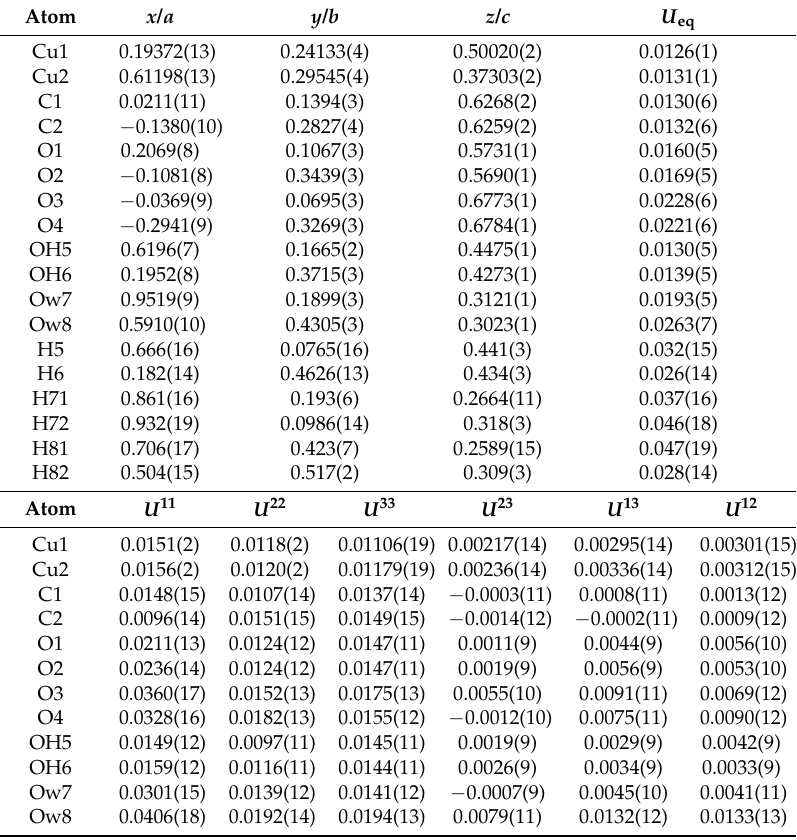
Table 4. Atom coordinates and displacement parameters [ U eq / U ij , Å 2